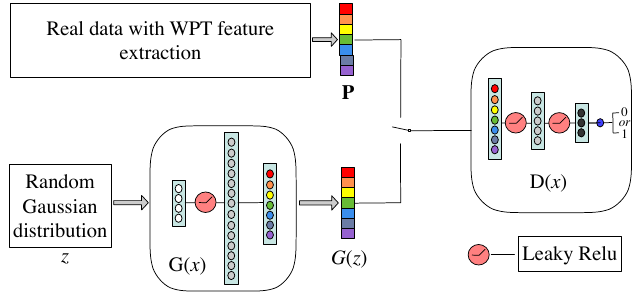
Figure 2. A block diagram of a GAN as used in this